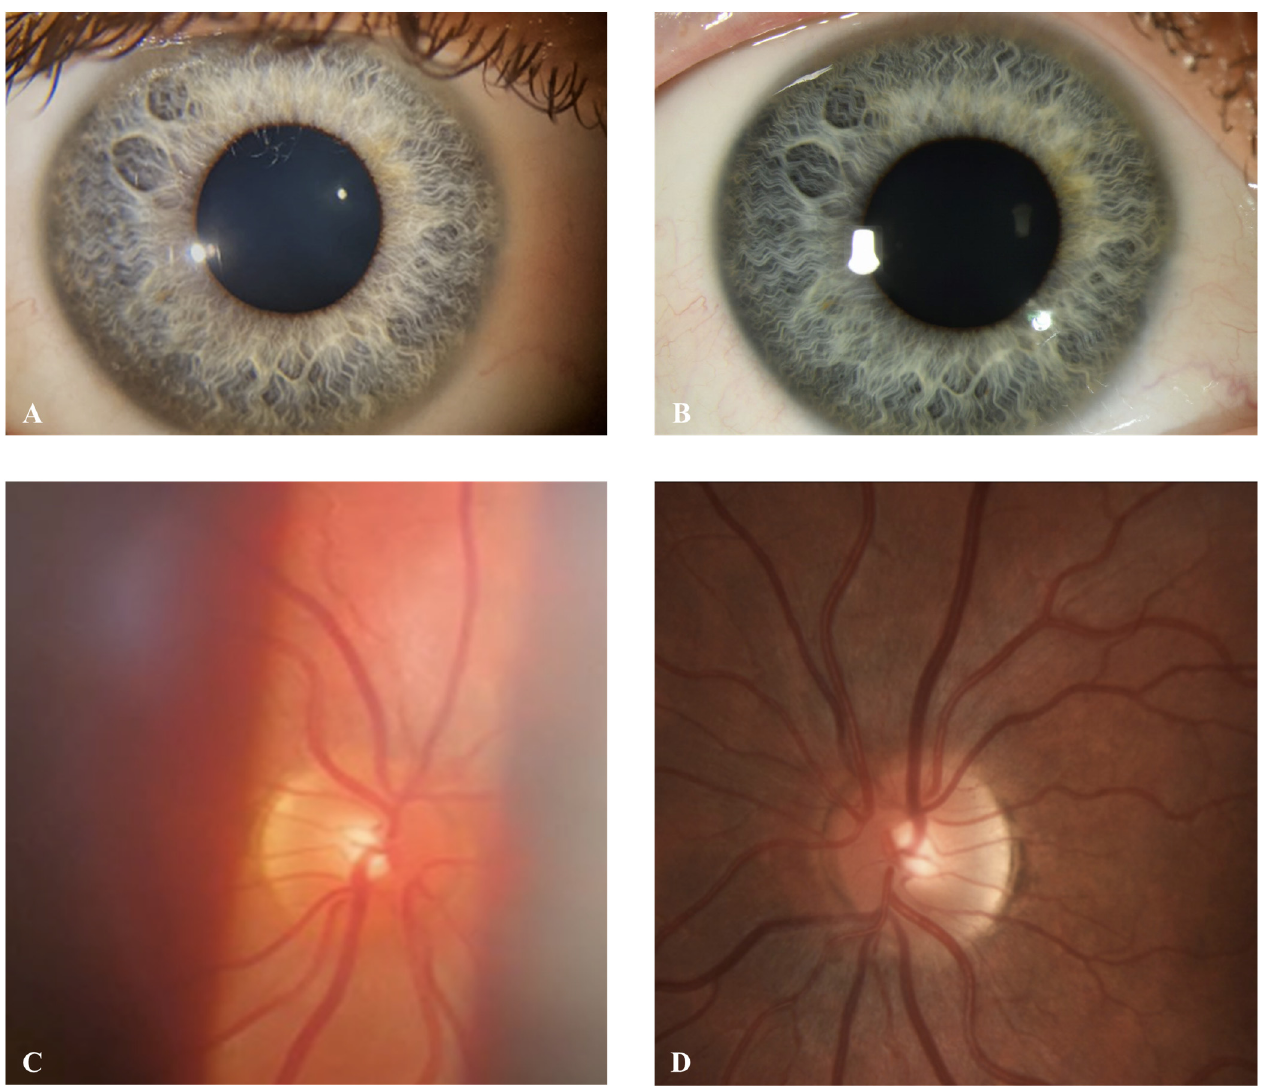
Figure 3. Comparison of smartphone images with photo studio images: ( A ) Anterior segment picture taken by smartphone; ( B ) Anterior segment picture taken by photo studio; ( C ) Posterior segment picture taken by smartphone. (D ) Posterior segment picture taken by photo studio.